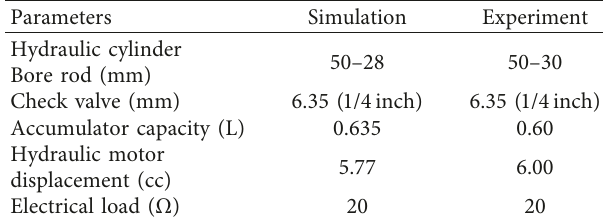
Table 11: Key component differences between model and test rig.